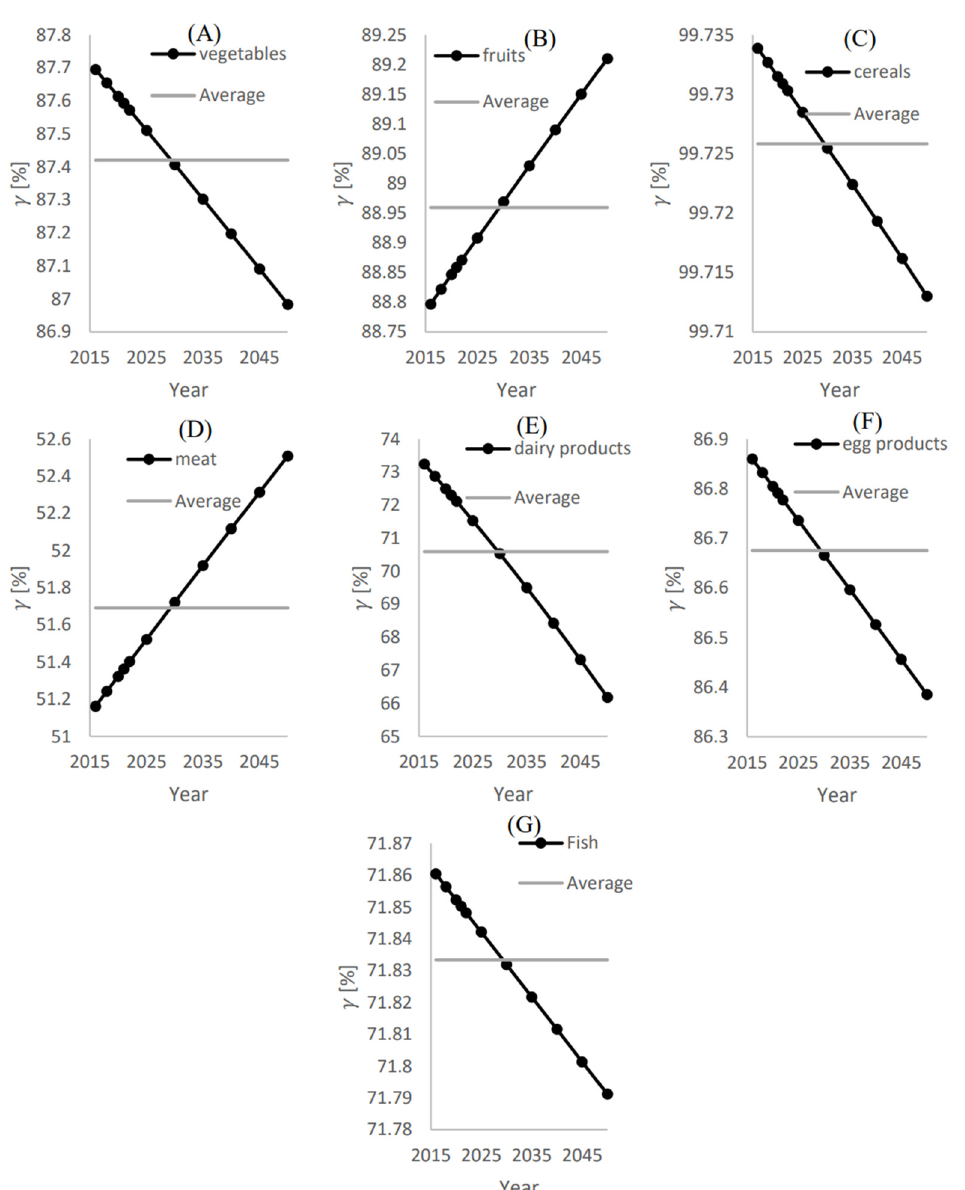
Figure 8. The annual and average ratios of the additional local food supply to achieve food-self sustainability ( x i , add ) to the local demand ( fl ) for ( A ) Vegetables, ( B ) Fruits, ( C ) Cereals, ( D ) Meat, ( E ) Dairy products, ( F ) Egg products, and ( G ) Fish.